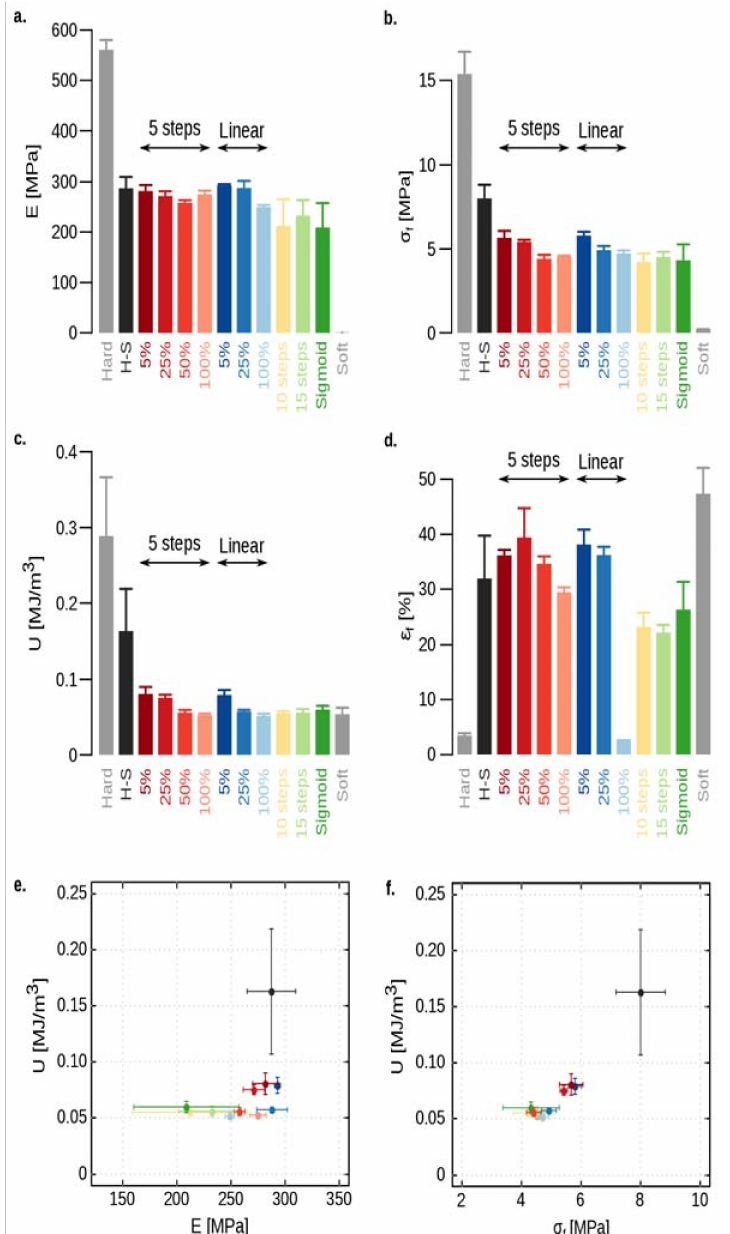
Figure 3. Bar-plots for the comparison of the mechanical properties of the specimens in ten groups, whichincludeelasticsti ff ness( a ), fracturestress( b ), fractureenergy( c ), andfinalstrain( d ). Thestatistical parameters of the calculated fracture properties are summarized in Table S2 of the supplementary document. An ANOVA analysis and a post-hoc Tukey honestly significant di ff erence (HSD) test were used to determine whether there was a significant di ff erence between di ff erent groups. The comparison tables are presented in Tables S3–S6 of the supplementary document. The Ashby plots compare the fracture energy with elastic sti ff ness ( e ) and fracture stress ( f ). The plots show the mean and standard deviations for each data point. The fracture properties of the monolithic hard and soft specimens are adopted from